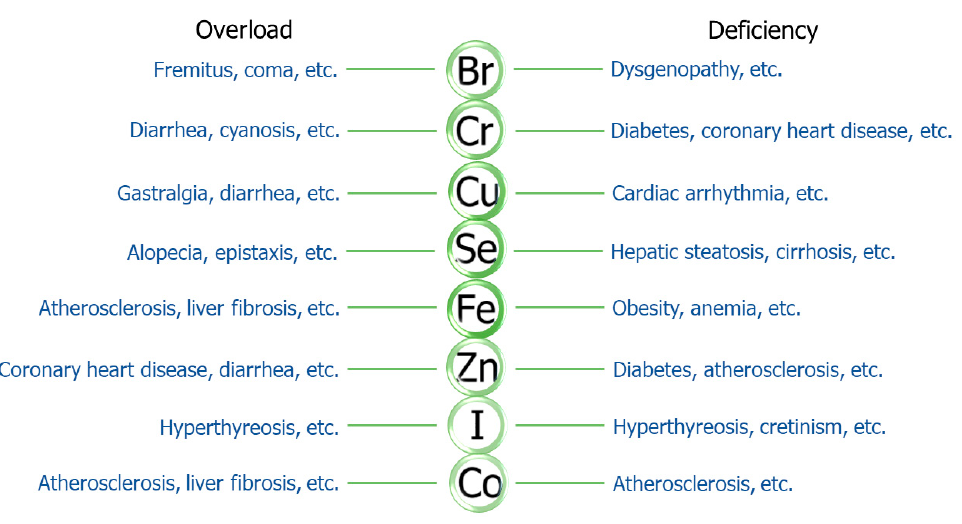
Figure 1. Trace elements and diseases. Overload and deficiency of multiple trace elements are closely correlated to the pathogenesis of numerous diseases. Br, Bromine; Cr, Chromium; Cu, Copper; Se, Selenium; Fe, Iron; Zn, Zinc; I, Iodine; Co, Cobalt.